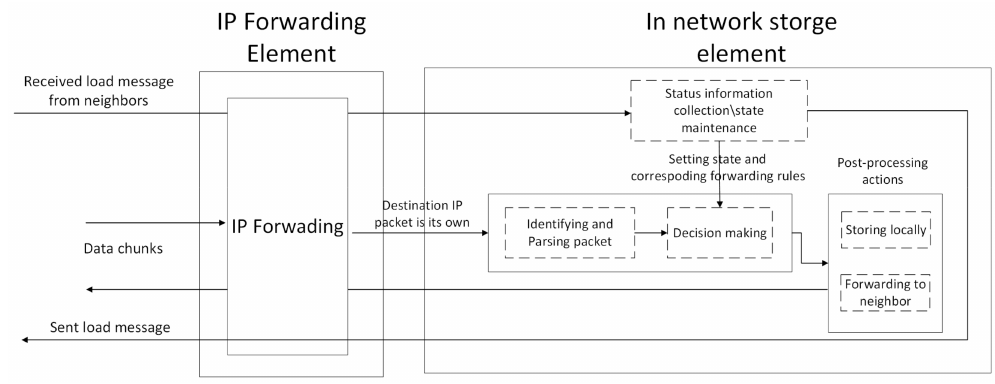
Figure 4. The extended network intermediate node